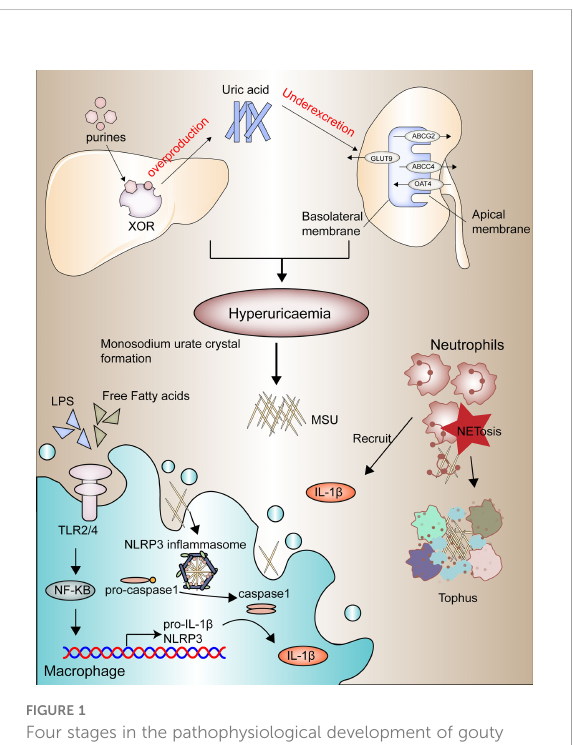
FIGURE 1 Four stages in the pathophysiological development of gouty